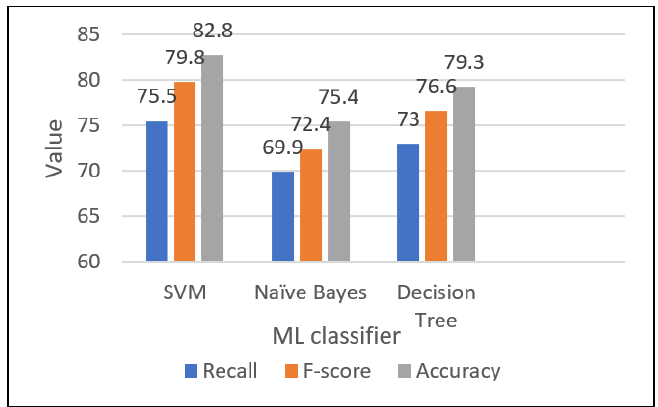
Figure 3. Classi fi ers relative performance for the proposed approach. Figure 3. Classifiers relative performance for the proposed